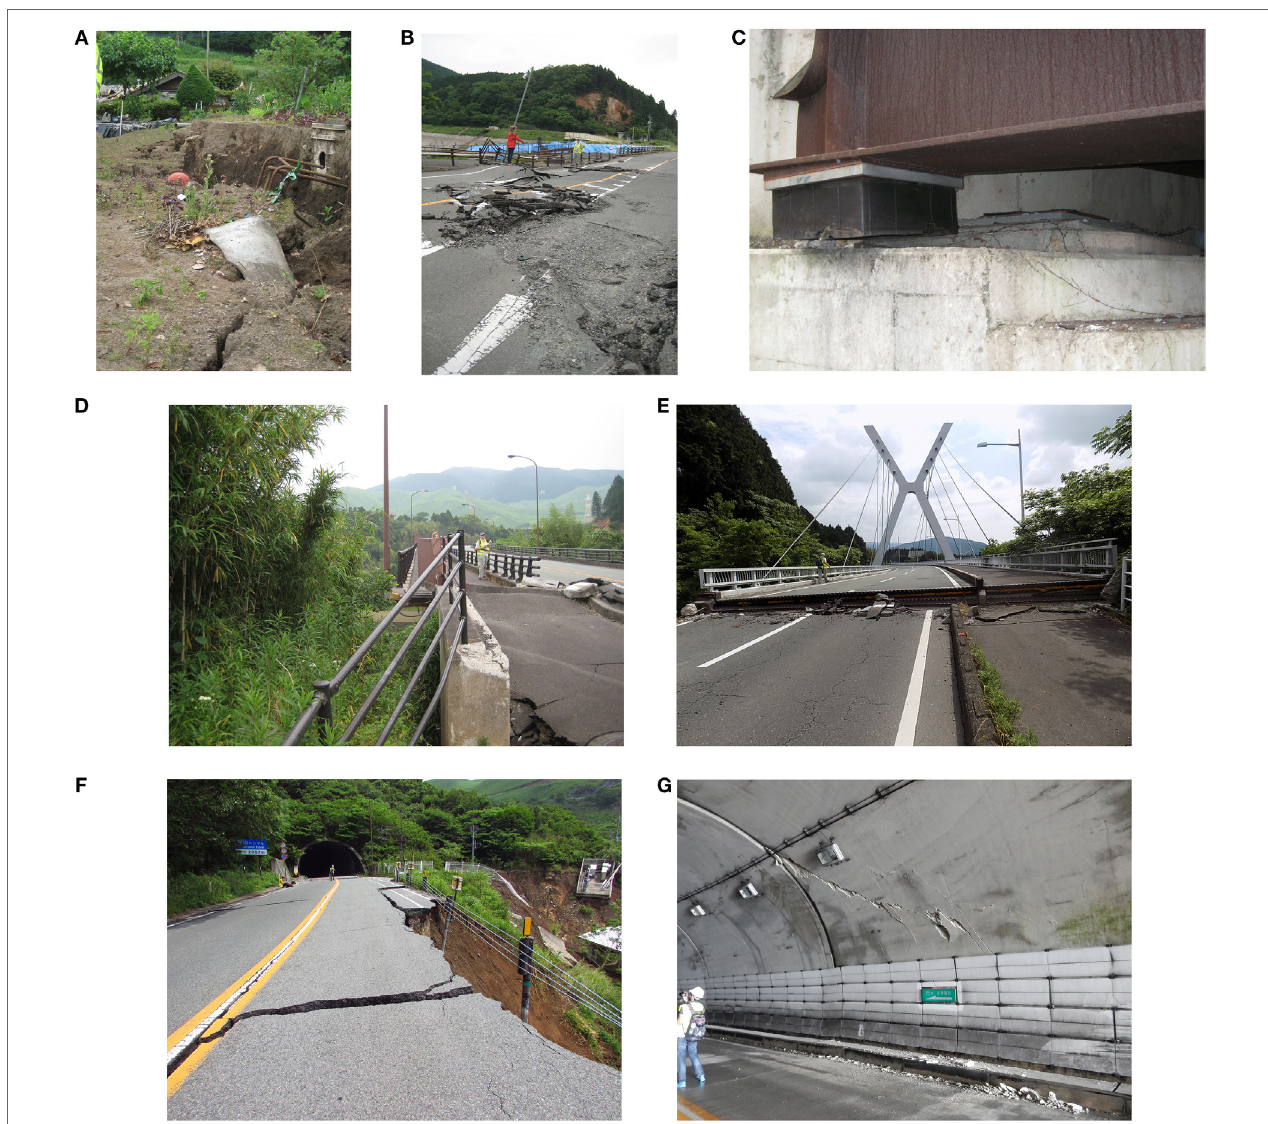
FigUre 16 | (a) Fault surface rupture in Mashiki Town (location 7 in region 2). (B) Fault surface rupture at the crest of Oogiribata dam (location 8 in region 2). (c) Shear fracture of bridge support underneath Oogiribata bridge (location 8 in region 2). (D) Damage to Oogiribata bridge (location 8 in region 2). (e) Damage to Kuwatsuru bridge (location 9 in region 2). (F) Road failure near Tawarayama tunnel (location 10 in region 2). (g) Cracks inside Tawarayama tunnel (location 10 in region